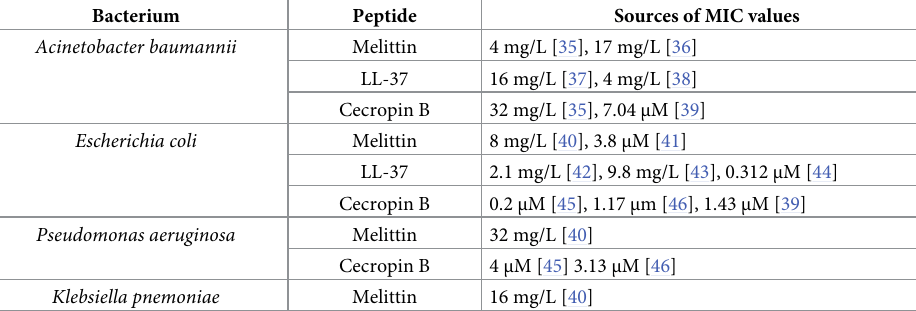
Table 2. Sources of minimum inhibitory concentration values used in Fig